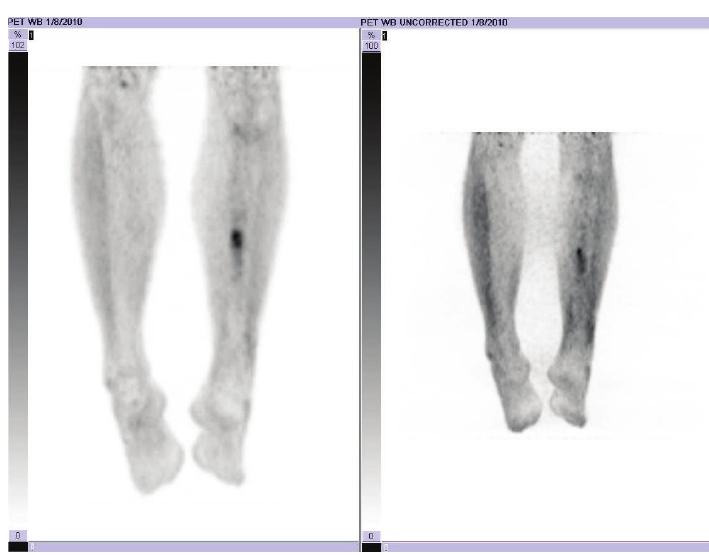
Figure 4: Posttreatment planar PET/CT image demonstrating recurrence of PET-avidity at site of original